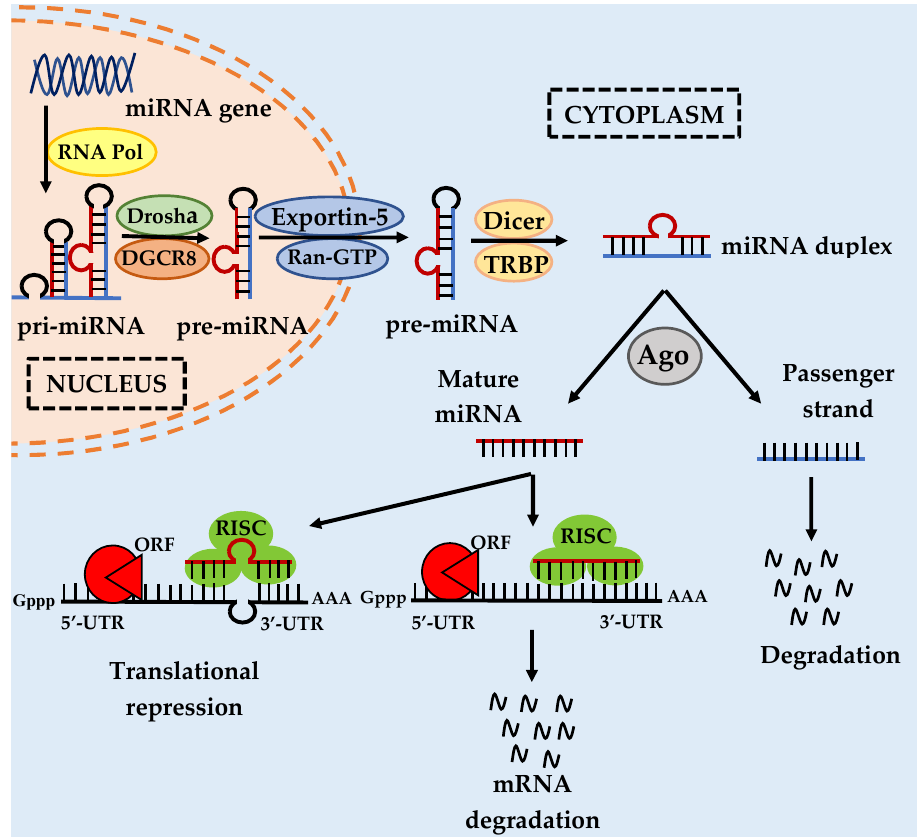
Figure 1. MicroRNA biogenesis and modulation of miRNA activity. miRNA genes are transcribed to produce primary miRNA transcripts (pri-miRNA) by RNA polymerase II. Drosha–DGCR8 complex cleaves the pri-miRNA into a precursor miRNA transcript (pre-miRNA) which is then transported from the nucleus into the cytoplasm via nuclear pore by exportin 5. In the cytoplasm, the pre-miRNA is further modified by the DICER and TRBP complex to form a mature miRNA duplex. The miRNA duplex is incorporated into an Argonaute (Ago) with RNA-induced silencing complex (RISC) and the duplex is unwound by helicase into two single-stranded miRNAs. The mature single-stranded miRNA can then bind to the target mRNA and exert its inhibitory function through translational block or degradation of the mRNA depending on the level of nucleotide complementarity. Reproduced with permission from Bhardwaj, A.; Singh, S.; Singh, A.P. MicroRNA-based cancer therapeutics: Big hope from small RNAs. Mol. Cell Pharmacol. 2010